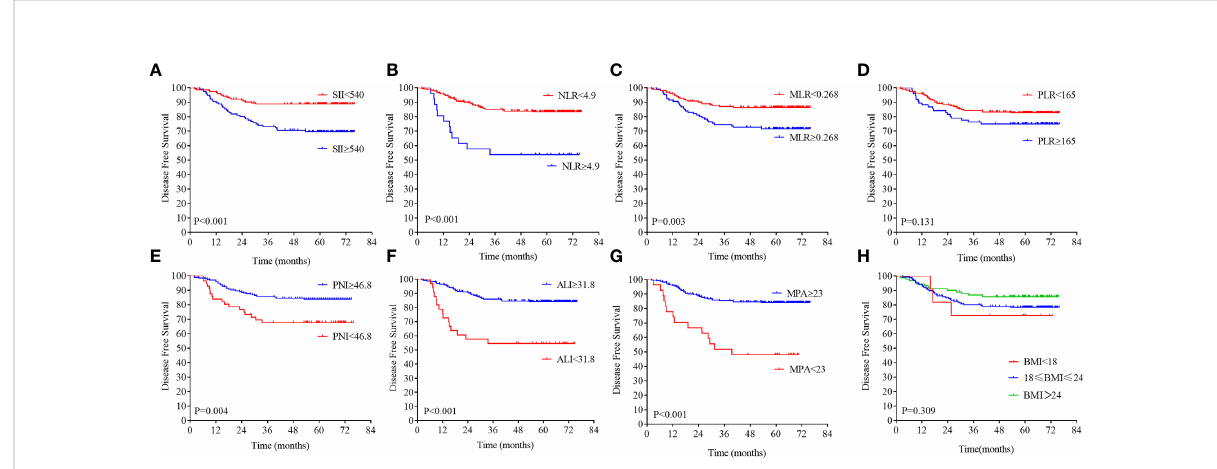
FIGURE 3 Kaplan – Meier analysis of the NLR, SII, PLR, MLR, PNI, ALI, MPA, and BMI level. The disease-free survival for the optimal cutoff point of the SII (A) , NLR (B) , MLR (C) , PLR (D) , PNI (E) , ALI (F) , MPA (G) , and BMI level (H)